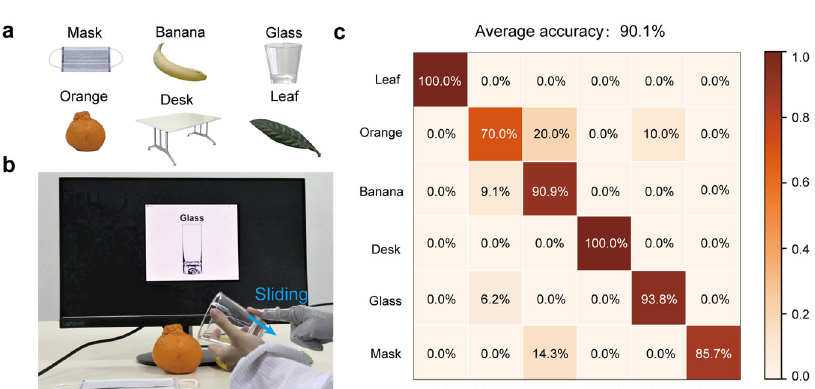
Fig. 5 The ability of the multifunction tactile system for material classi fi cation and roughness discrimination. a Photographs of six different objects with various materials and similar roughness, containing PET fi lm, PI fi lm, silicon wafer, stainless steel sheet, glass and silk fi lm. b Details of the corresponding responses of the bioinspired sensor during sliding on above objects with the constant normal force of 2 N and sliding velocity of 100 mm min − 1 . c Confusion matrix of materials discrimination from the model trained by XGBoost. Predicted label refers to the recognized results, and true label refers to the true materials. d SEM images of six different silicon wafers with various roughness with the same depth (40 μ m) and six kinds of spacing and width. Scale bar represents 500 μ m. e Details of the corresponding responses of the bioinspired sensor during sliding on above silicon wafers with the constant normal force of 2 N and sliding velocity of 100 mm min − 1 . f Confusion matrix of roughness discrimination from the model made XGBoost. Predicted label refers to the recognized results, and true label refers to the true roughness. The color bar represents the normalized accuracy.